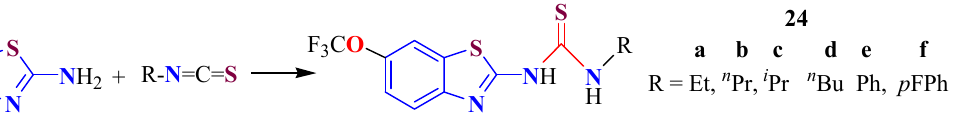
Figure 5. 6-trifluoromethoxy-TBTs 24a - f derived from Riluzole. Some 4/6-substituted-phenyl-TBTs 25 were synthesized by the reaction of substituted-2ABT with the corresponding substituted phenyl-isothiocyanate in absolute ethanol, Scheme 10 [131]. Compounds 25 were condensed with malonic acid in acetyl chloride to obtain 1-(4/6-substituted-BT-2-yl)-3-phenyl-2-thiobarbituric acid derivatives 26 . All the synthesized compounds were characterized by elemental analysis, infrared (IR), hydrogen nuclear magnetic resonance 1 H NMR, and Mass spectral studies. Compounds 25 and 26 were screened for their entomological and antibacterial activities. All the synthesized compounds were screened for antibacterial activity at a concentration of 200 μ g/mL and 100 μ g/mL in DMF using streptomycin and ceftazidime as standard against Gram positive and negative bacteria. Among the synthesized compounds, 26a , 26f , and 26g compounds were found to possess broad-spectrum activities. However, the activities were much less than those of standard antibacterial agents used. These compounds also showed potent antiulcer, anti-inflammatory, and antitumor activities as well as antifeedant activity and acaricidal activity against Spodoptera litura and Tetranychus urticae , respectively. From the results, these compounds would be better used in drug development to combat bacterial infections and would be better used as antifeedant and acaricidal activities in the future as well.